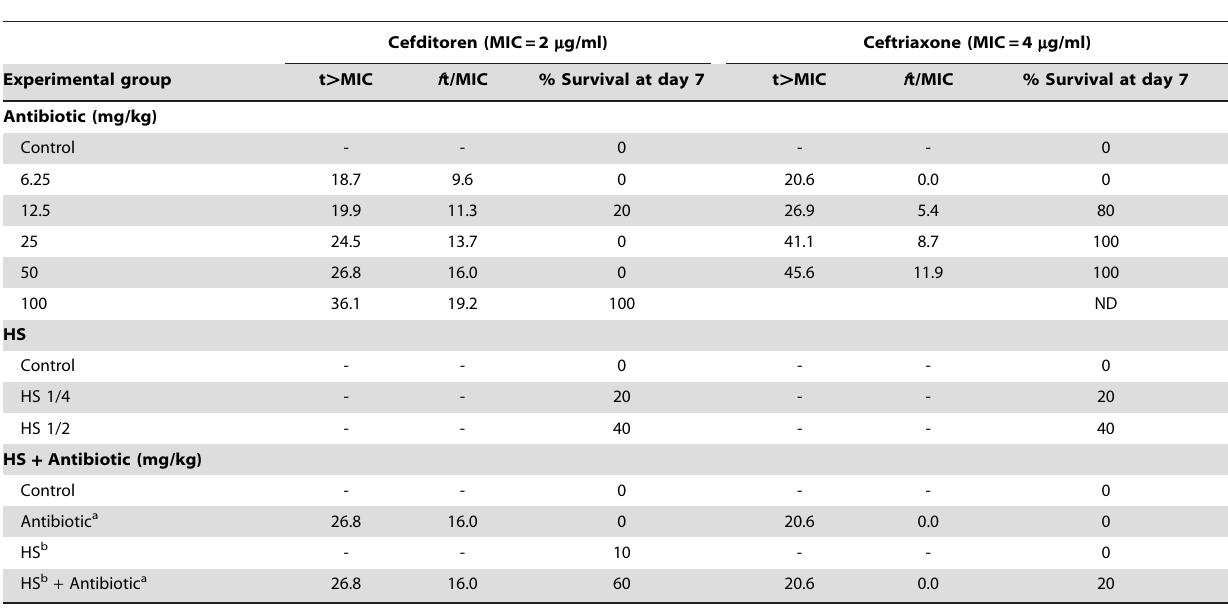
Table 2. Pharmacodymanics and efficacy against Strain 2.